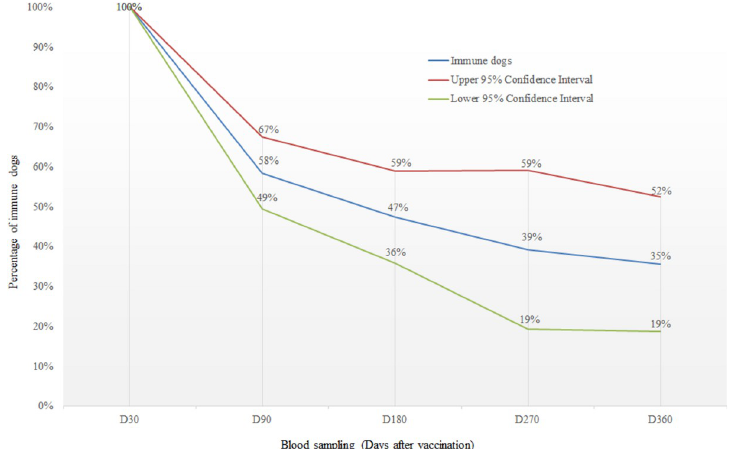
Fig 2. Percentage of dogs developed binding antibody titres � 0.5EU/ml at days 90 (n = 115), 180 (n = 72), 270 (n = 23), and 360 (n = 32) after vaccination surveyed in Flores Island, Indonesia in 2018–2019. The dogs developed binding antibody titres � 0.5EU/ml at day 30 (n = 171) were taken as study population.